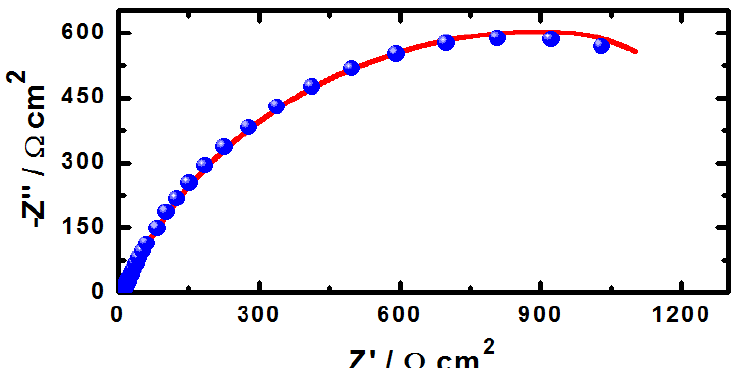
Figure 9. EIS Nyquist plot for pure iron after 40 min immersion in 4.0 wt % NaCl solution; symbols represent the measured data and solid line represents the best fit using the equivalent circuit shown in Figure 8.